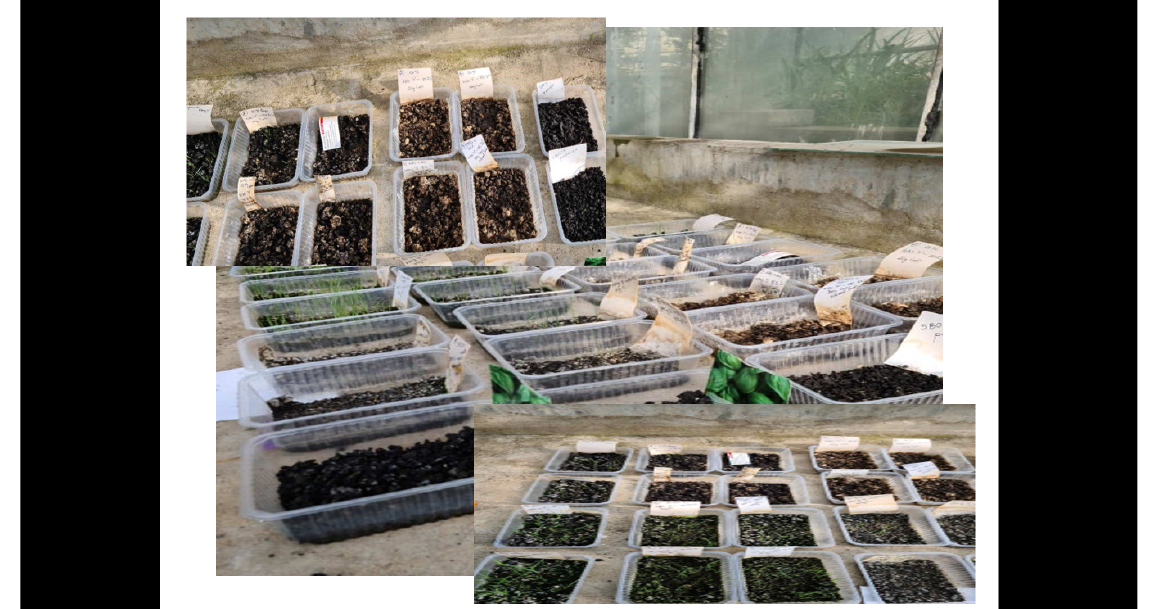
Figure 1. Composted variants in greenhouse conditions.